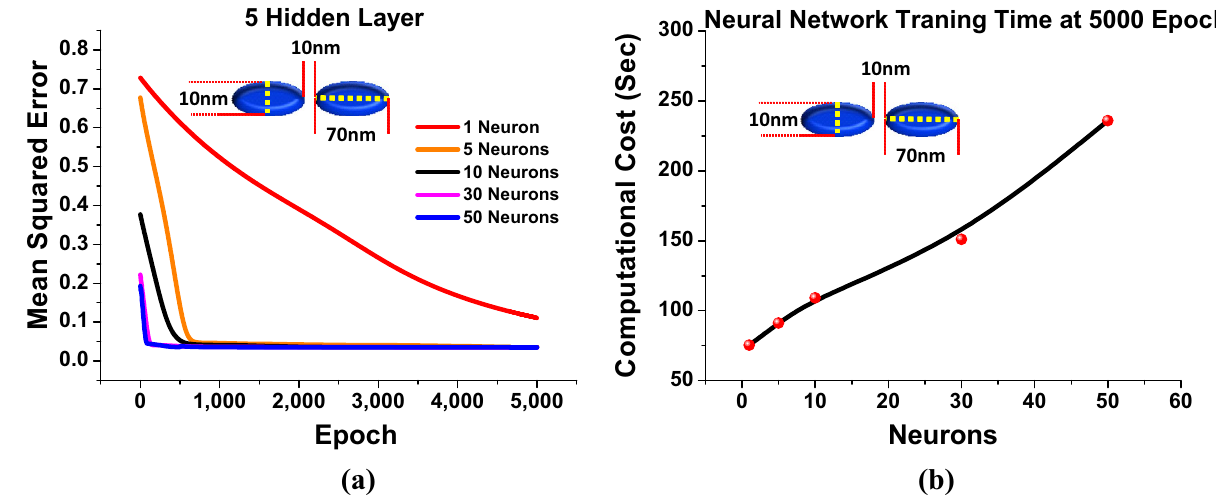
Figure 8. Hidden layer = 5 and Epoch = 5000 ( a ) Shows the comparison of MSEs at different neurons ( b ) Represents the trend of the computational cost with respect to the variations in epoch = 5000 when neuron = 10 are used, as shown in Fig. 8a. For neuron = 10, shown by a black curve shows the expeditious reduction in MSEs values = 0.38 at epoch = 1 and decreases till epoch = 700 until stabilised. For neuron = 30, pink curve shows the further decrements in MSEs values = 0.22 at neurons = 30 and steadies after epoch = 200. The corresponding spectral response is also shown in the Fig. 7b. Finally, for neurons = 50 shown by a blue curve have been adopted to see further improvement in the MSEs values, when the MSEs values = 0.18 at epoch = 1 and quickly stabilised after epoch = 50. Hence, neurons = 50 was considered for further observations as it is showing lower MSEs values and faster convergence. The corresponding predicted spectral values are also shown in Fig. 5. Figure 8b shows the effect of computational cost at different neurons when hidden layer = 5 and